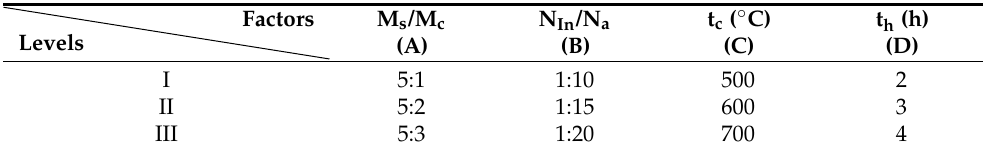
Table 1. Factors and levels for orthogonal experiment.